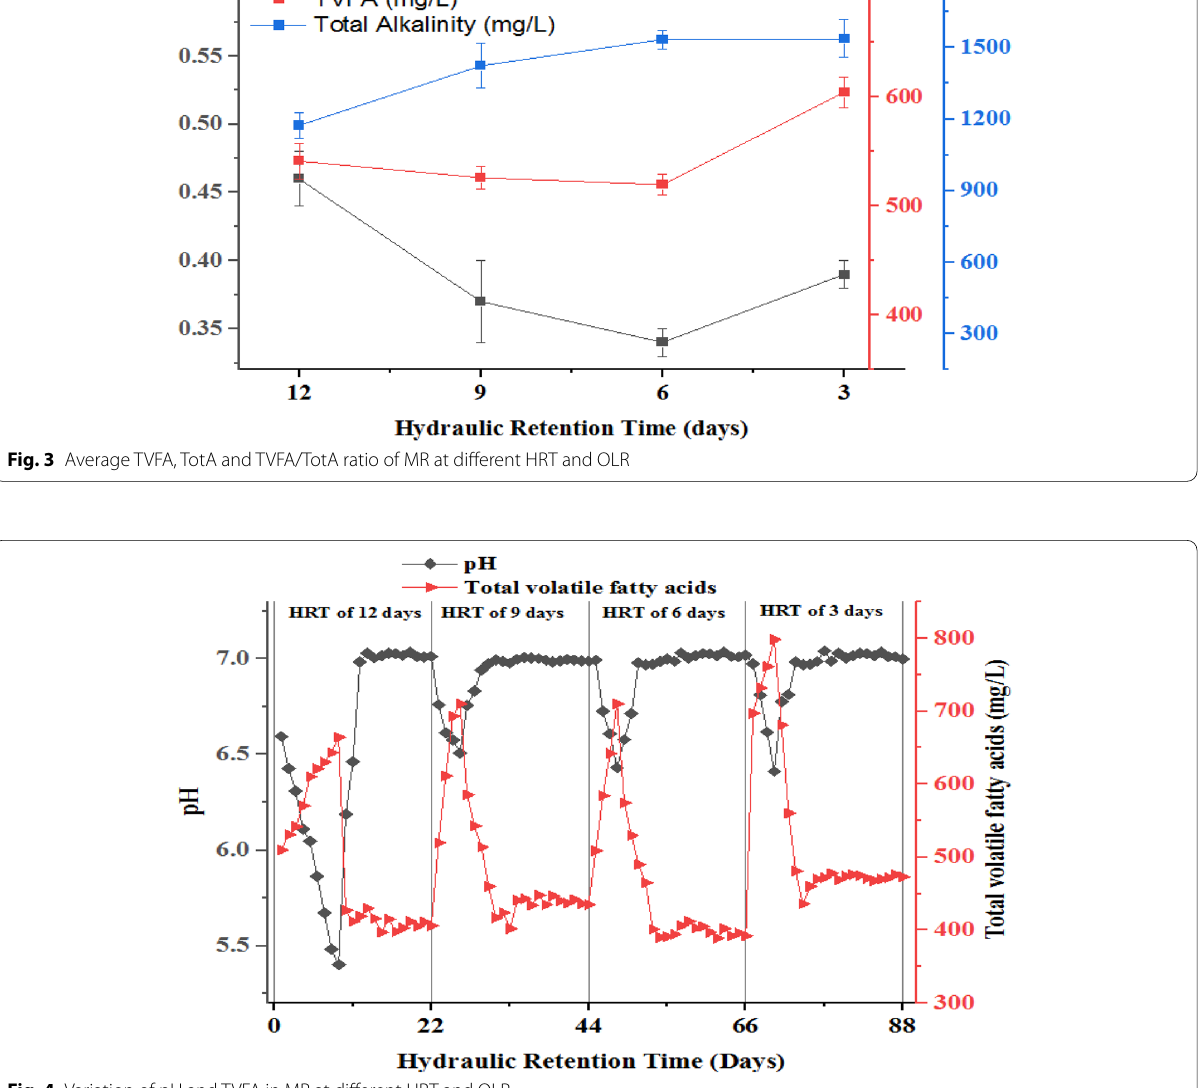
Fig. 4 Variation of pH and TVFA in MR at different HRT and